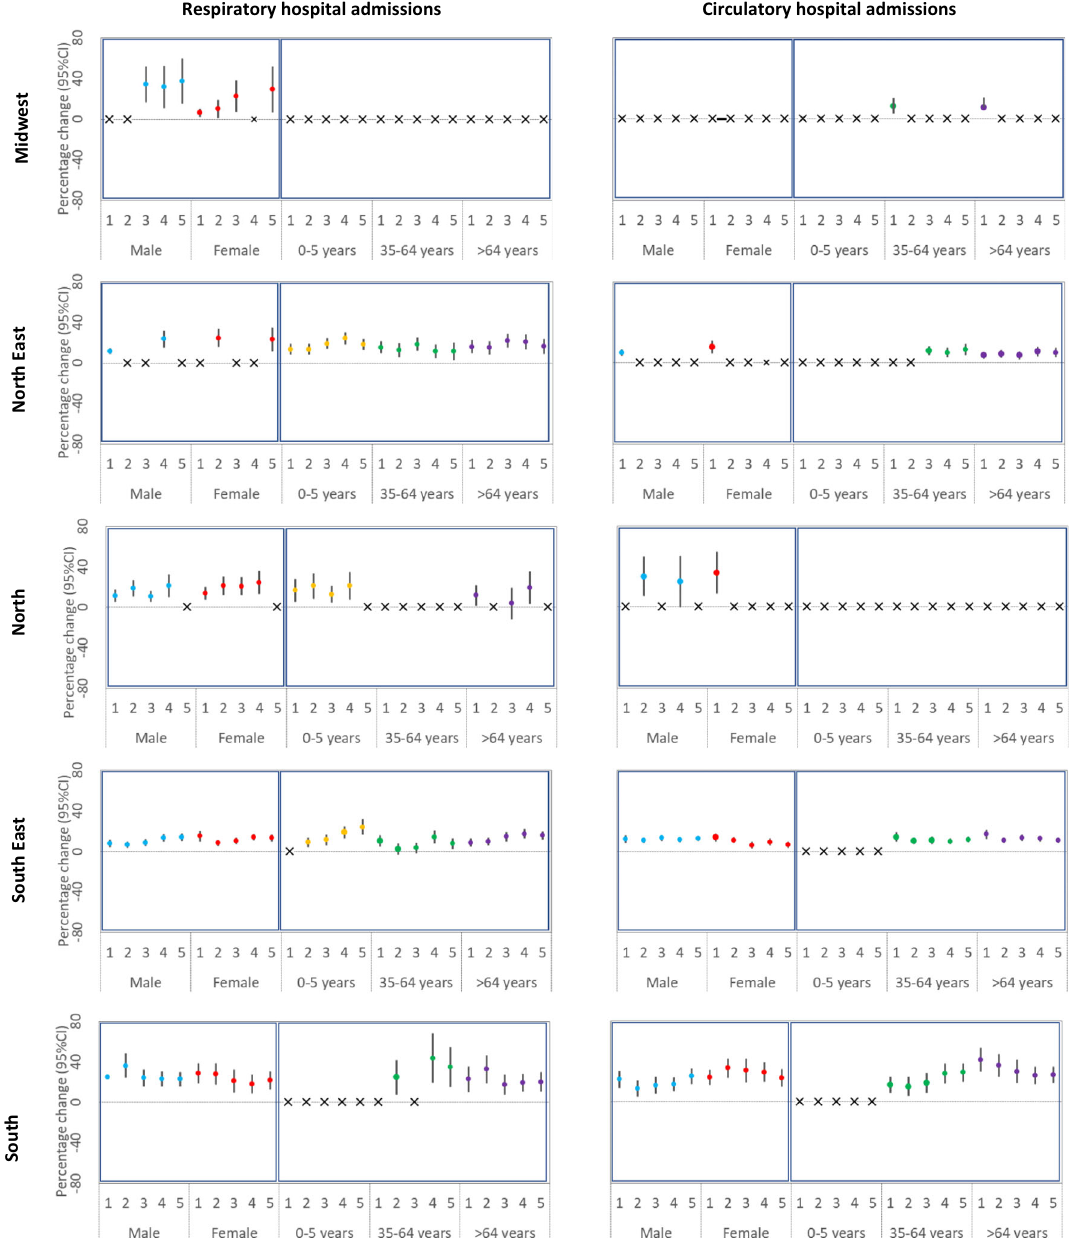
Fig. 3 Regional percentage increase in risk (and 95% CI) of hospital admissions associated with wild fi re-related PM2.5 in wild fi re waves for the moving averages 1 – 5 days by sex and age. Note 1: x -axis indicates the moving averages. Note 2: “ x ” means that there were very large groups of ties, which (a large number of health events (de fi ned as case day) is out of a large number of subjects (case plus control days). The algorithm in the Survival package may refuse to undertake the task (the computation is infeasible) due to over fl ow for the subscripts. Note 3: Red (Female), blue (Male), orange (0 – 5 years), green (35 – 64 years), and purple (>64 years). Norte 4: Left panels (respiratory hospital admissions), right panels (circulatory hospital admissions), panels on the fi rst row (Midwest), panels on the second row (North East), panels on the third row (North), panels on the fourth row (South East), and panels on the last row (South).). Note 5: n = 2,044,038